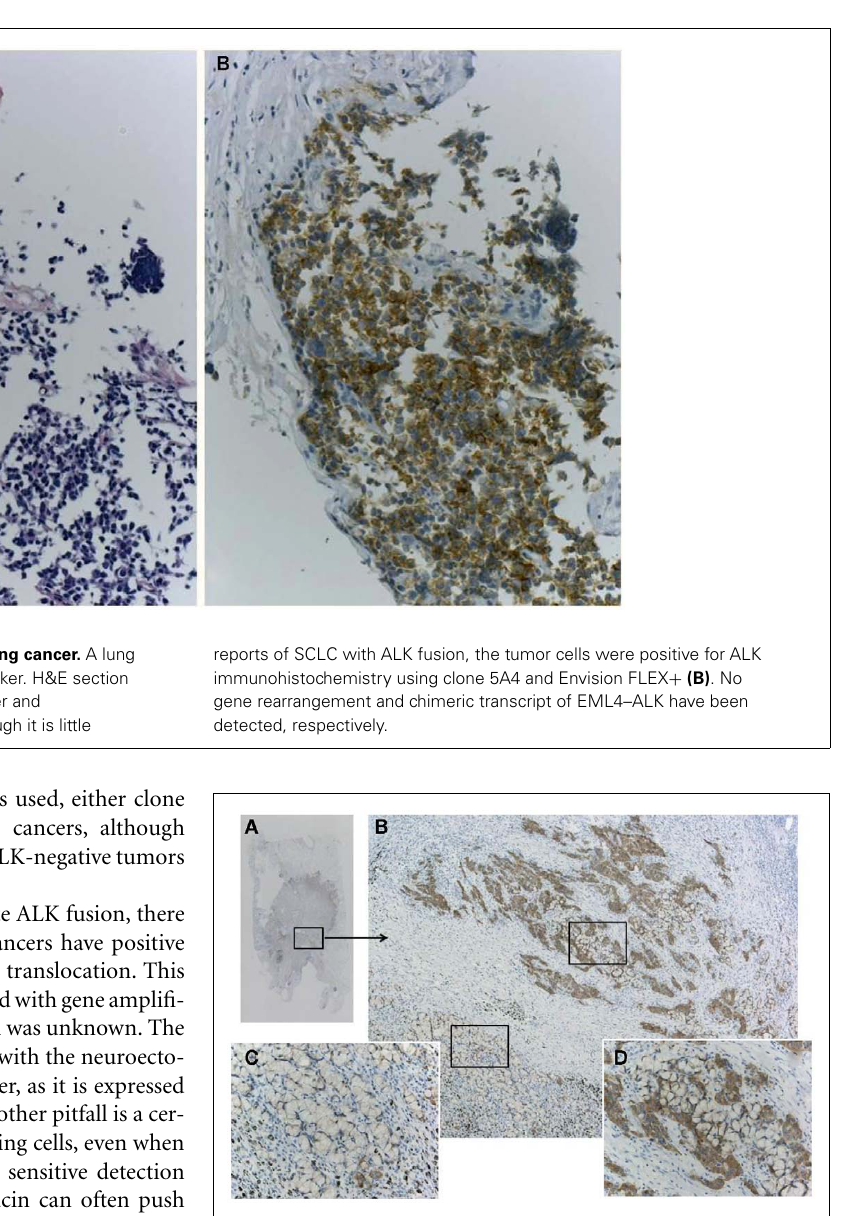
FIGURE 7 |A pitfall of false negative immunohistochemistry in the mucinous component of adenocarcinoma, including signet ring cell carcinoma. Although the adenocarcinoma (A) was confirmed to harbor ALK fusion with both FISH and RT-PCR, immunohistochemistry using clone D5F3 and Envision FLEX + showed various intensity of positive reactions (B) . An upper part of the tumor cells (D) presented strong positivity, while the lower part showing signet ring cell carcinoma morphology appeared to be negative (C) . Large amount of intracellular mucin pushes out cell cytoplasm outward to the rim.This false negative reaction does not indicate heterogeneity of ALK fusion, because split signals was demonstrated in both